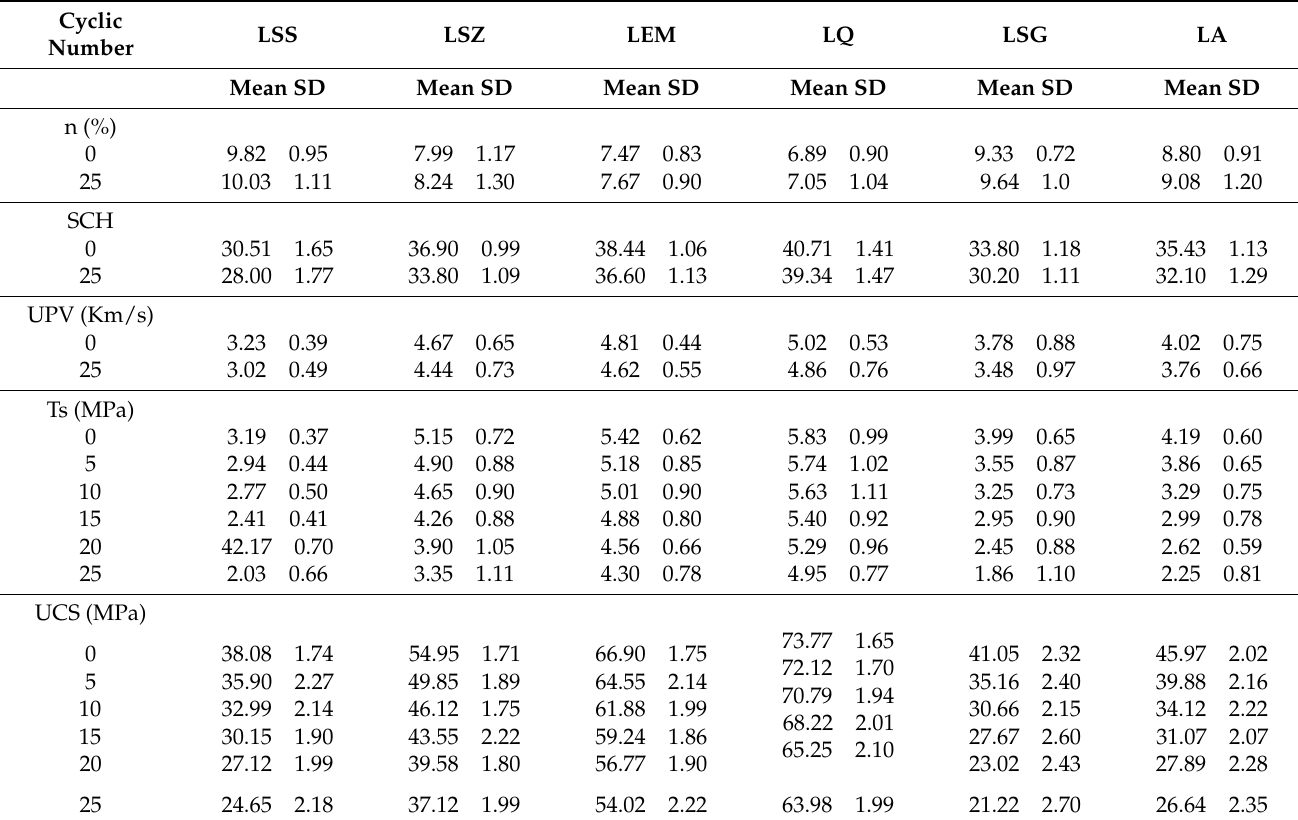
Table 5. Average values and standard deviations of physico-mechanical properties due to salt crystallization